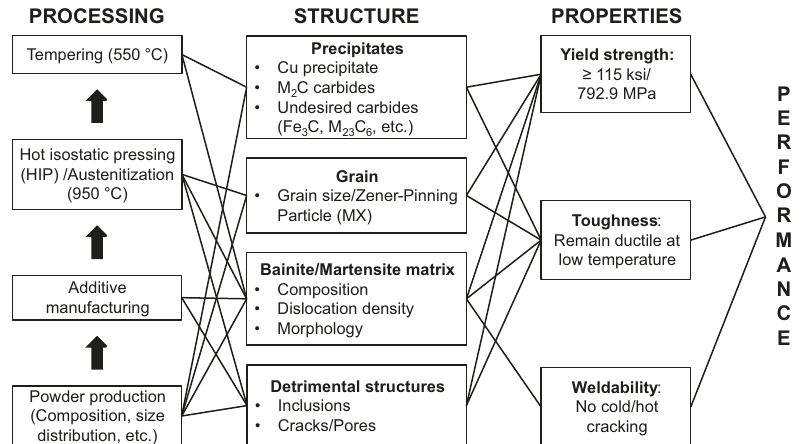
Fig. 1 Systems design chart for AM HSLA-115. A schematic diagram showing the relationship betweening key properties, structure and process of HSLA-115. Each line represents a relationship/model between two